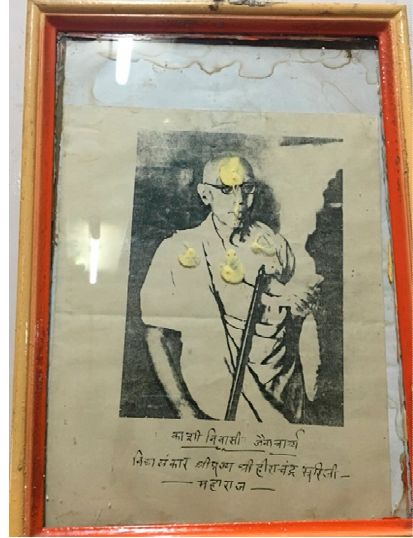
Figure 8. Copy of a photograph of Ā c ā rya H ī r ā candras ū ri displayed and worshiped in the up āś raya of the Cint ā ma ṇ i P ā r ś van ā th Temple at R ā m Gh ā ṭ . Twentieth